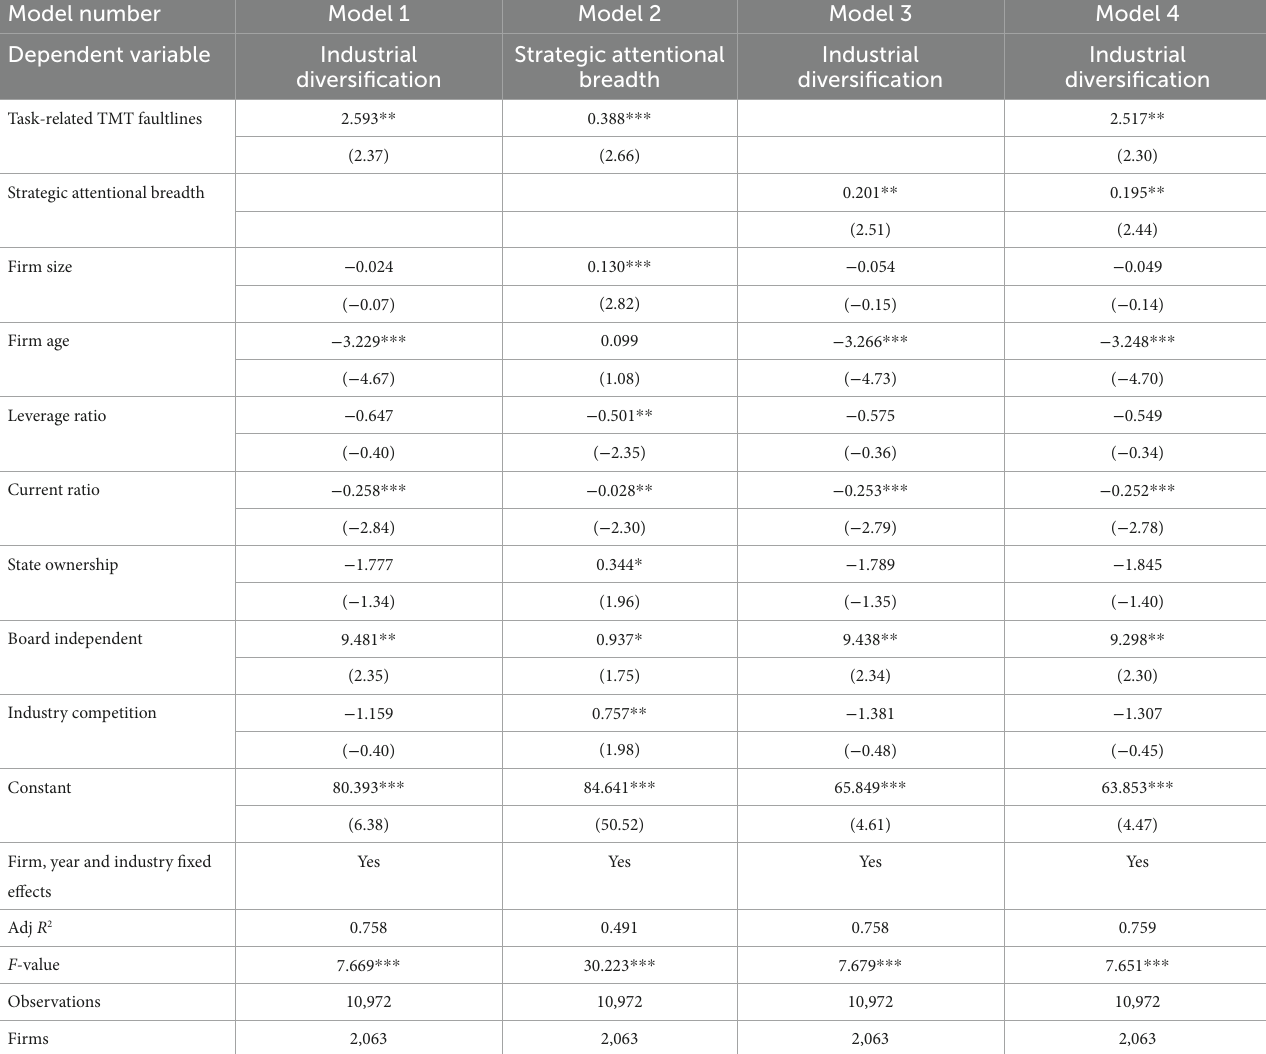
TABLE 2 Panel fixed-effects regression of the relationship between task-related TMT faultlines and corporate industrial